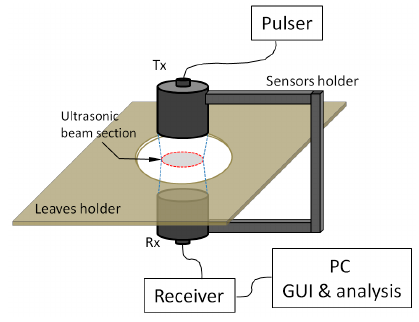
Figure 1. Schematic representation of the NC-RUS system.